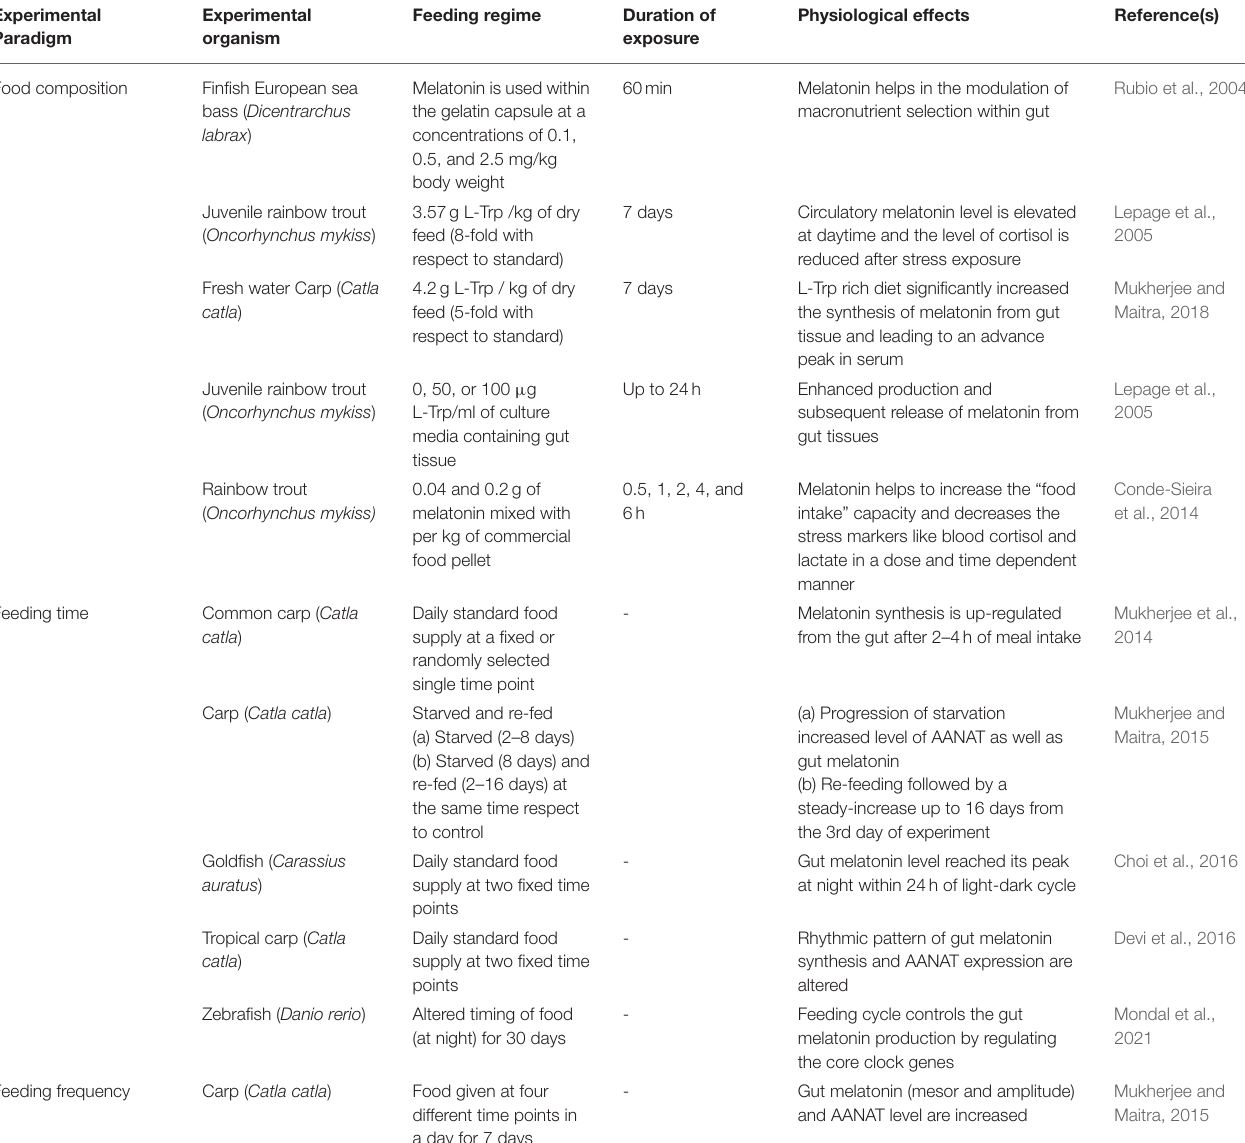
TABLE 1 | Use of melatonin (directly or its precursor L-Trp) as fish feed additive in different experimental model animals and its effects on various physiological functions are